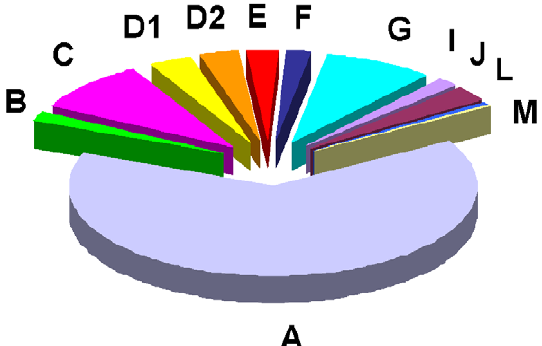
Fig. 1. Relative prevalences of complementation groups in FA. Re- sults are based on the first 248 FA families classified by the Euro- pean Fanconi Anemia Research Program (1994–2003). This number includes the reference cell lines for groups A, B, C, D1, and D2. The absolute numbers per group were as follows: A: 159; B: 4; C: 23; D1: 8; D2: 8; E: 6; F: 5; G: 21; I: 4; J: 8; L: 1, M: 1. Figure reproduced, with permission, from the thesis of M.